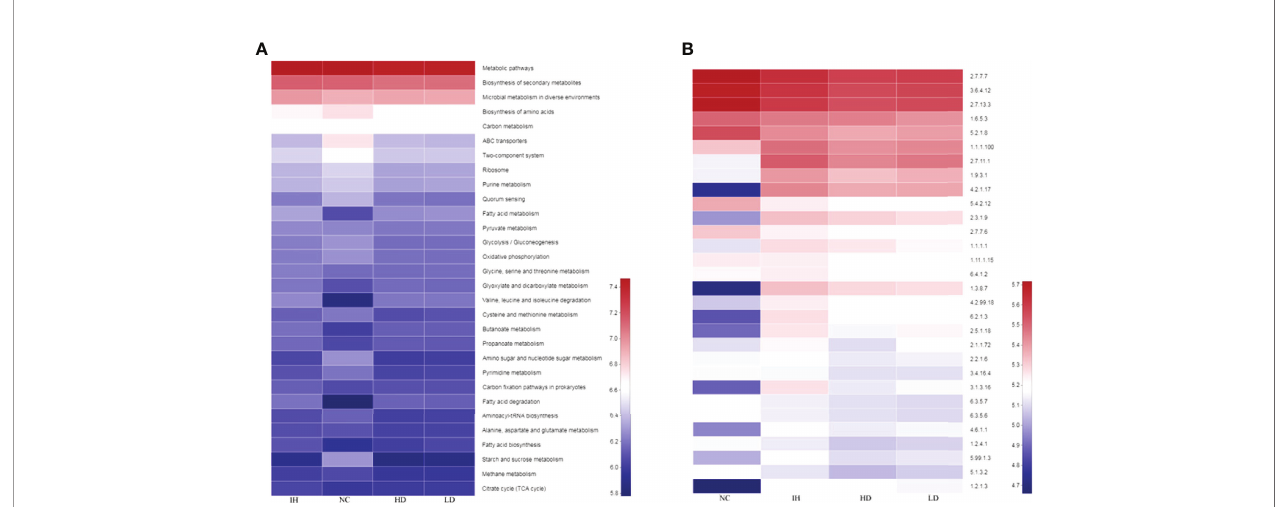
FIGURE 6 | Predictions of metabolic pathways and enzymes within the intestinal microbiota. (A) Predicted metabolic pathways within the intestinal microbiota; (B) predicted enzymes within the